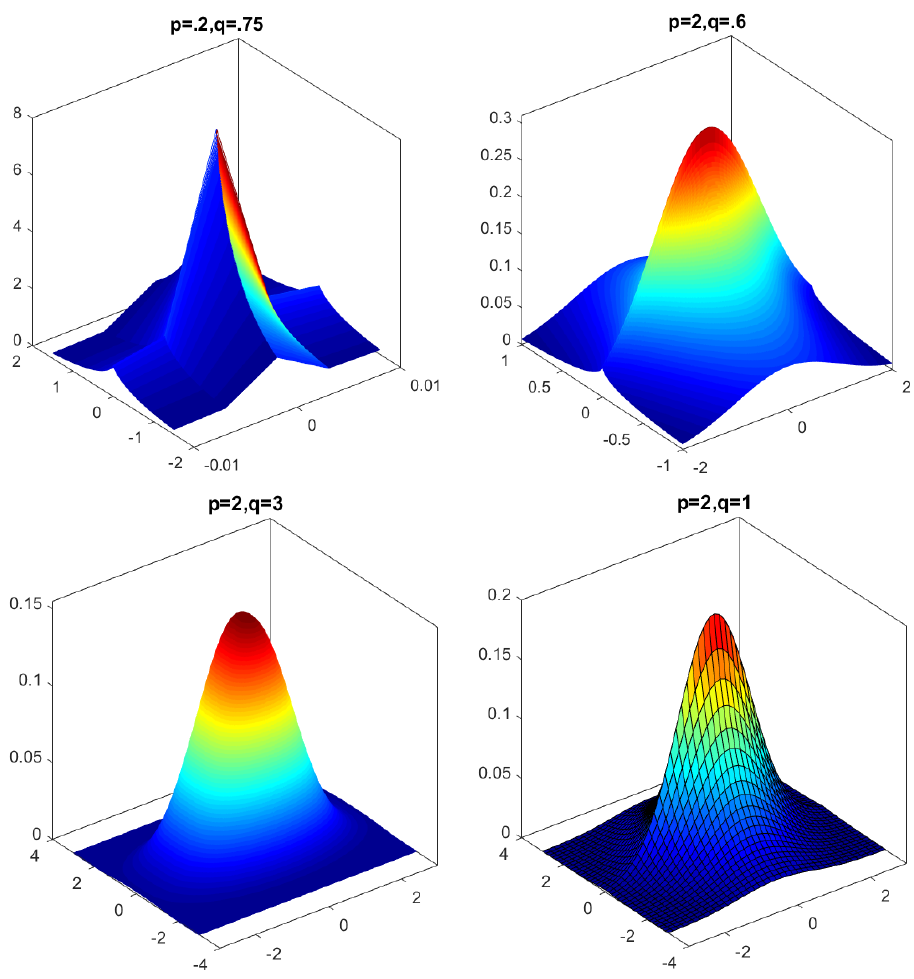
Figure 12. Power exponential density φ ( x , y ) = C [ p , q ] · e −| x | p / p −| y | q / q for particular values of [ p , q ]